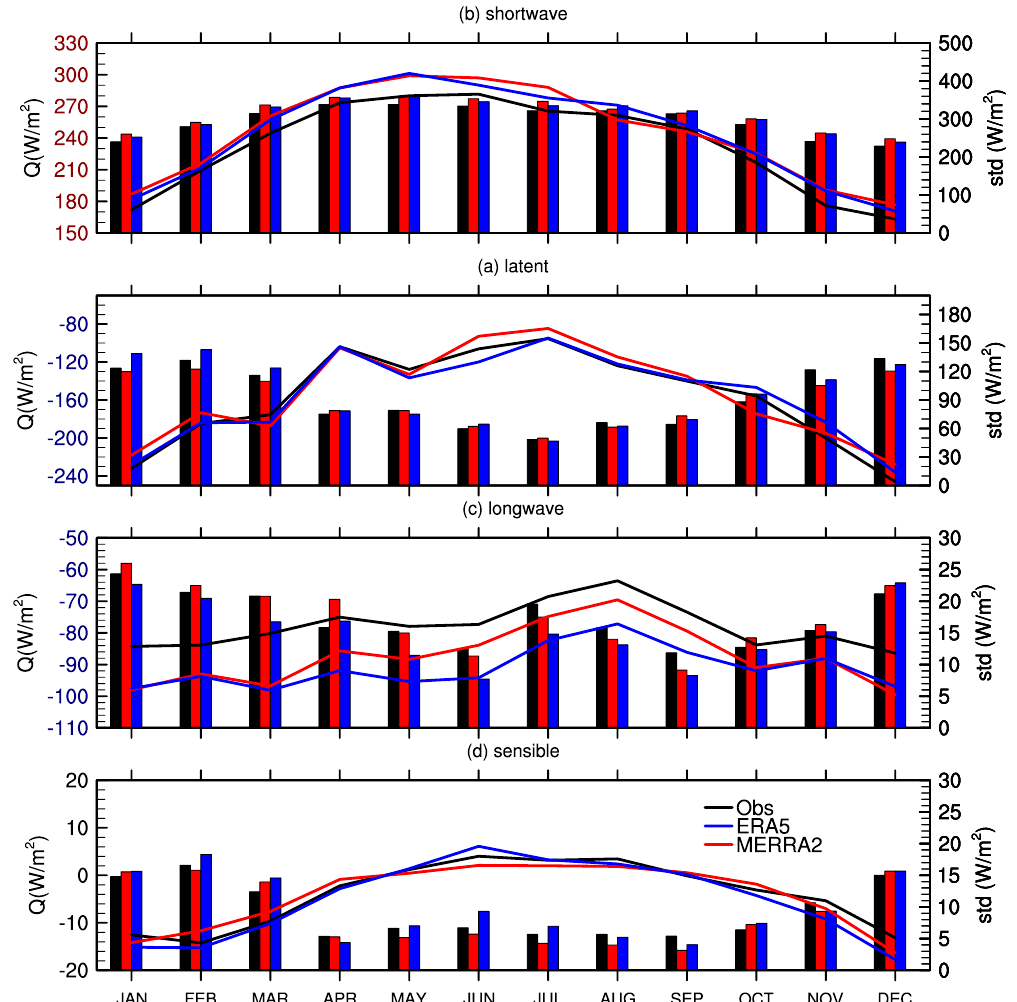
Figure 11. Monthly-averaged heat fluxes components at the WHOI/KAUST buoy site (22.17 ◦ N; 38.50 ◦ E) obtained from in situ observations, ECMWF-ERA5, and NASA-MERRA2 reanalyses. ( a ) net shortwave radiation, ( b ) latent heat flux, ( c ) net longwave radiation, and ( d ) sensible heat